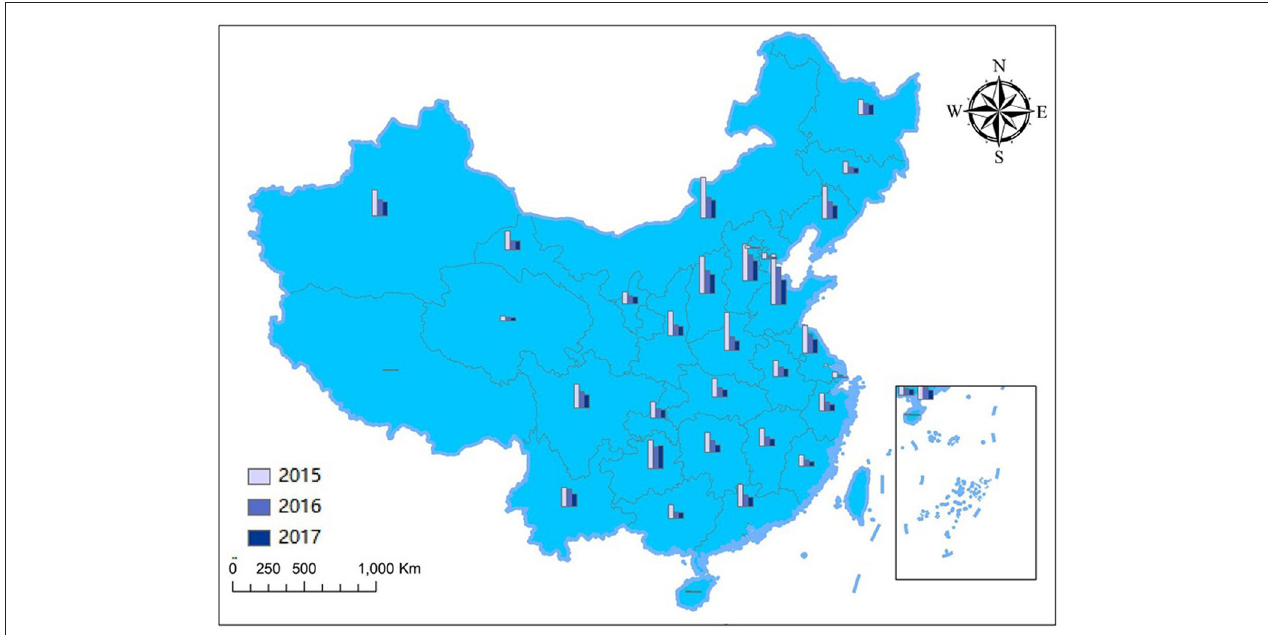
FIGURE 1 | Changes in the SO 2 emissions across provinces and regions from 2015 to 2017.